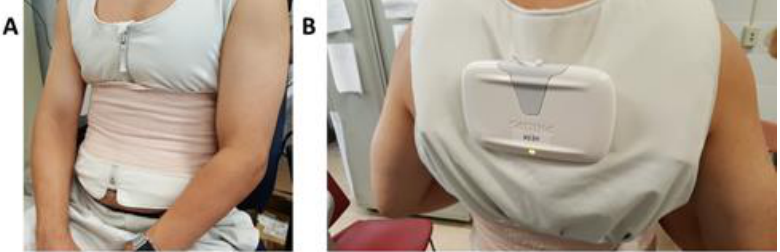
Figure 2. Subject wearing a fluid accumulation vest (FAV): ( A ) Front of the vest showing the compression strap and ( B ) measuring device connected via Bluetooth to a smartphone.